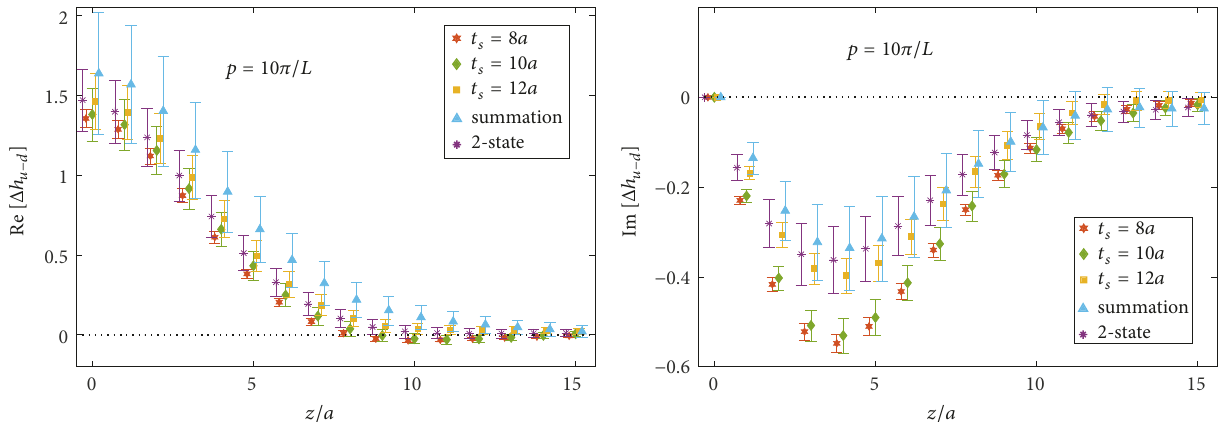
Figure 23: Real (left) and imaginary (right) part of the matrix element for the ETMC’s helicity PDF from the plateau method ( 𝑡 𝑠 value given in label), the two-state fits (using all 𝑡 𝑠 values), and the summation method. Nucleon momentum is 10𝜋/𝐿 ≃ 1.38 GeV. Source: [216], reprinted with permission by the Authors.